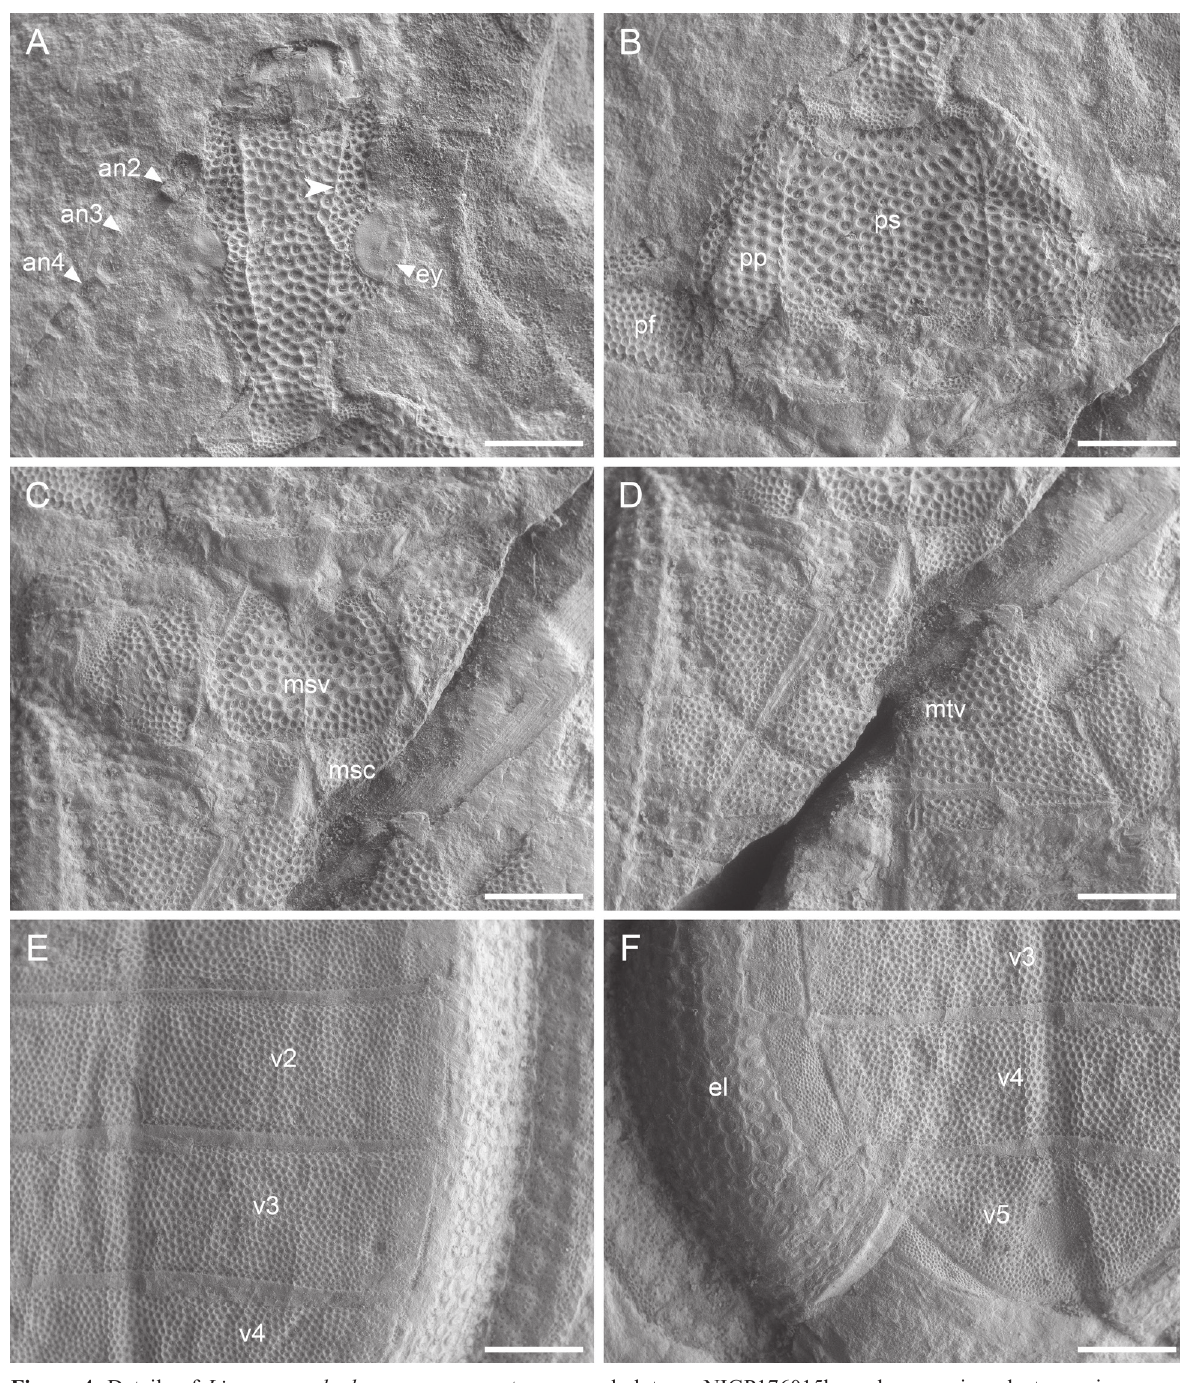
Figure 4. Details of Limnomma daohugouense gen. et sp. nov., holotype, NIGP176015b, under scanning electron microscopy. A. Head, with gula sutures highlighted (arrowhead); B. Prothorax; C. Mesothorax; D. Metathorax; E. Middle part of abdomen; F. Abdominal apex. Abbreviations: an2–4, antennomeres 2–4; el, elytron; ey, compound eye; msc, mesocoxa; msv, mesoventrite; mtv, metaventrite; pf, profemur; pp, propleuron; ps, prosternum; v2–5, ventrites 2–5. Scale bars: 1